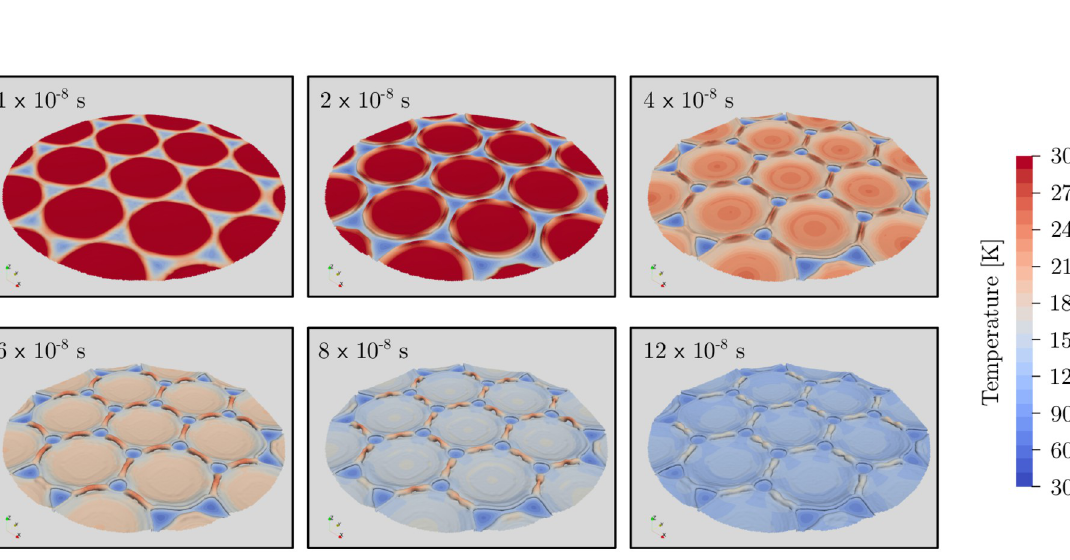
PLOS ONE | https://doi.org/10.1371/journal.pone.0282266 February 27, 2023 11 /